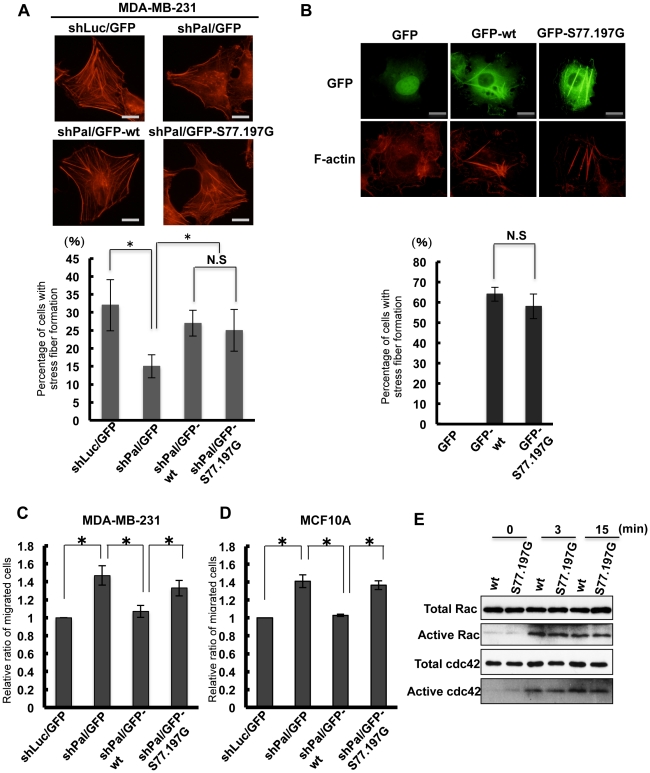
Phosphorylation of Ser77 and Ser197 controls cell migration.(A) Cells were cultured on glass coverslips for 24 h and fixed with paraformaldehyde. Cells were stained with rhodamine-conjugated phalloidin to visualize the actin cytoskeleton. (Scale bar = 15 µm) To quantitate cells with stress fiber formation, 50 cells for each cell line were evaluated and the graph shows the percentage of cells with stress fiber formation. Three independent experiments were performed. Each bar represents mean ± SD. (N.S; P>0.05, *P<0.01) (B) Cos7 cells were transfected with either GFP-wt or GFP-S77.197G palladin. Twenty-four hours later, cells were fixed and stained with rhodamine-conjugated phalloidin. (Scale bar = 15 µm) To quantitate cells with thick stress fiber formation, 30 transfected cells were evaluated and the graph shows the percentage of cells with thick stress fiber formation. Three independent experiments were performed. Each bar represents mean ± SD. (N.S; P>0.05) (C) Cell migration was examined using a modified Boyden chamber. Three independent experiments were performed, and relative ratios of migrated cells are indicated (means±SD; *P<0.01). (D) Cell migration was examined using a modified Boyden chamber. Three independent experiments were performed, and relative ratios of migrated cells are indicated (means ±SD; *P<0.01). (E) shPal/GFP-wt and shPal/GFP-S77.197G cells (MDA-MB-231) were serum-starved and stimulated with EGF for the indicated time points. Cells were lysed and incubated with GST-fused GST-PAK-PBD fusion protein bound to glutathione-agarose beads. Beads were subjected to western blot with anti-Rac or anti-Cdc42 antibody. Total Rac or cdc42 protein was detected by immunoblotting of cell lysates.